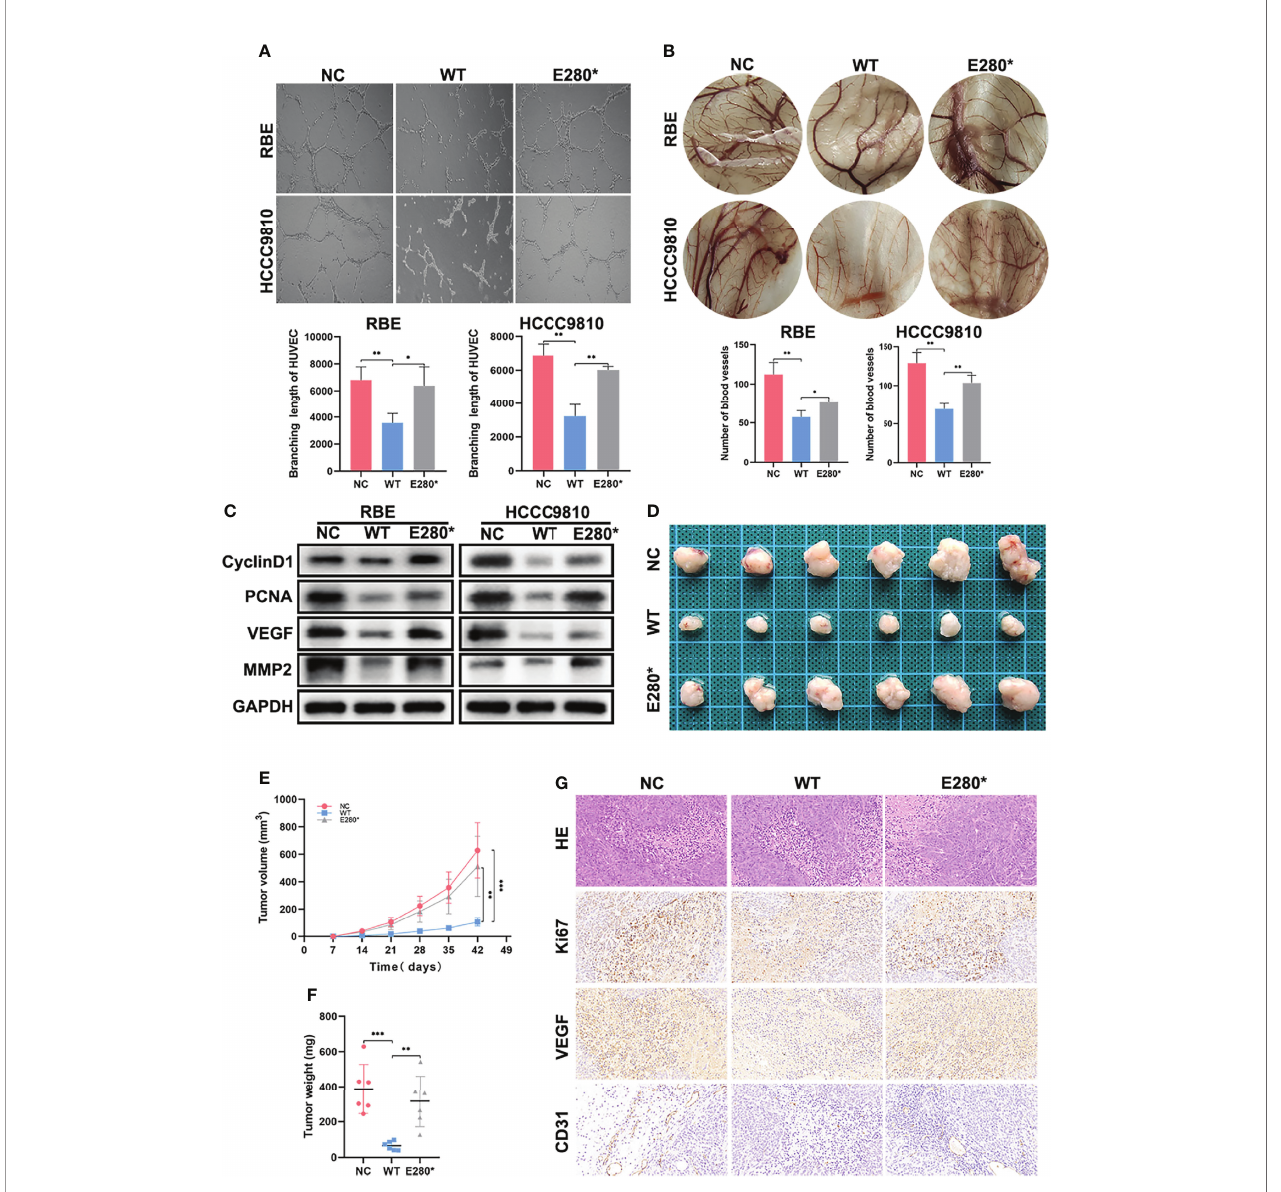
FIGURE 3 | ROBO1 E280 * reversed the inhibitory effects of ROBO1 WT on the angiogenesis and tumorigenesis of cholangiocarcinoma (CCA). (A) The branching length of HUVEC was signi fi cantly reduced by ROBO1 WT conditioned medium (CM) treatment and partially recovered by ROBO1 E280 * CM treatment. (B) Chorioallantoic membrane assays showed a descending trend of vessel numbers in the ROBO1 WT group and a recovering trend in the ROBO1 E280 * group. (C) Western blotting analysis showed a reverse trend of proliferative markers (cyclin D1 and PCNA) and angiogenic markers (VEGF and MMP2) in the ROBO1 E280 * group compared with the ROBO1 WT group. (D) Xenograft tumors in nude mice generated with RBE cells transfected with LV-ROBO1 WT , LV-ROBO1 E280 *, and LV-NC. (E, F) The growth of xenografts was suppressed in the ROBO1 WT group and rescued in the ROBO1 E280 * group. (G) Ki67, EVGF, and CD31 expression in different groups of xenografts. *P < 0.05, **P < 0.01, ***P <